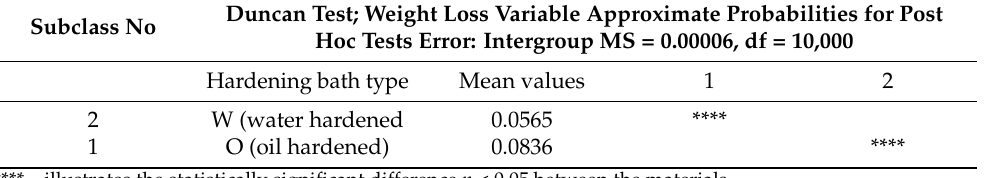
Table 12. The results of the Duncan test for the wear value for Vanadis 60 SuperClean steel worn in light soil. Subclass